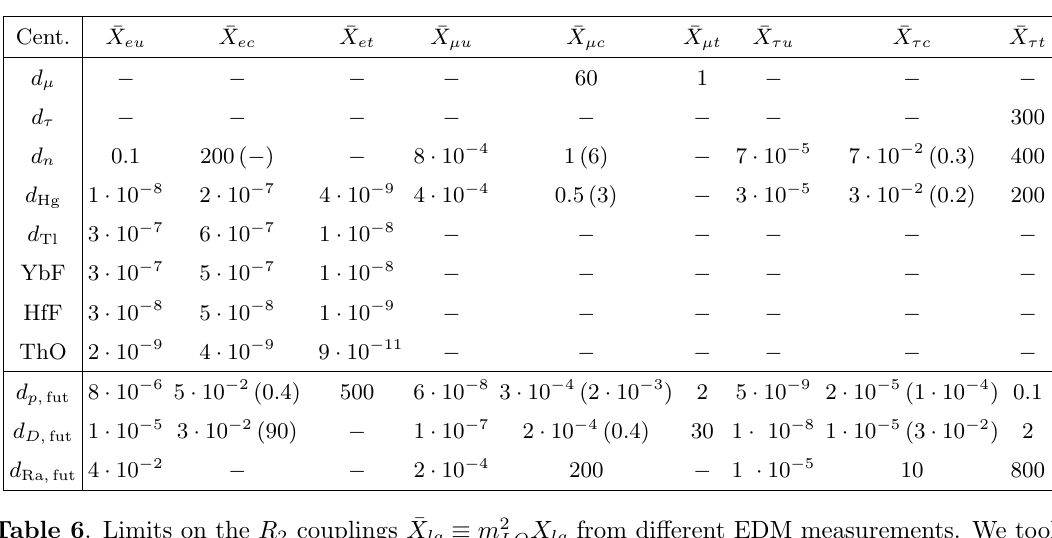
Table 6 . Limits on the R 2 couplings (cid:22) X lq (cid:17) m 2 X lq from di(cid:11)erent EDM measurements. We took LQ m LQ = 1 TeV and assumed the central values for all matrix elements. Given the uncertain nature of the charm tensor charge we also show the limits obtained with g c ! 0 in brackets, whenever T this has an impact. The last three rows show the expected limits from future